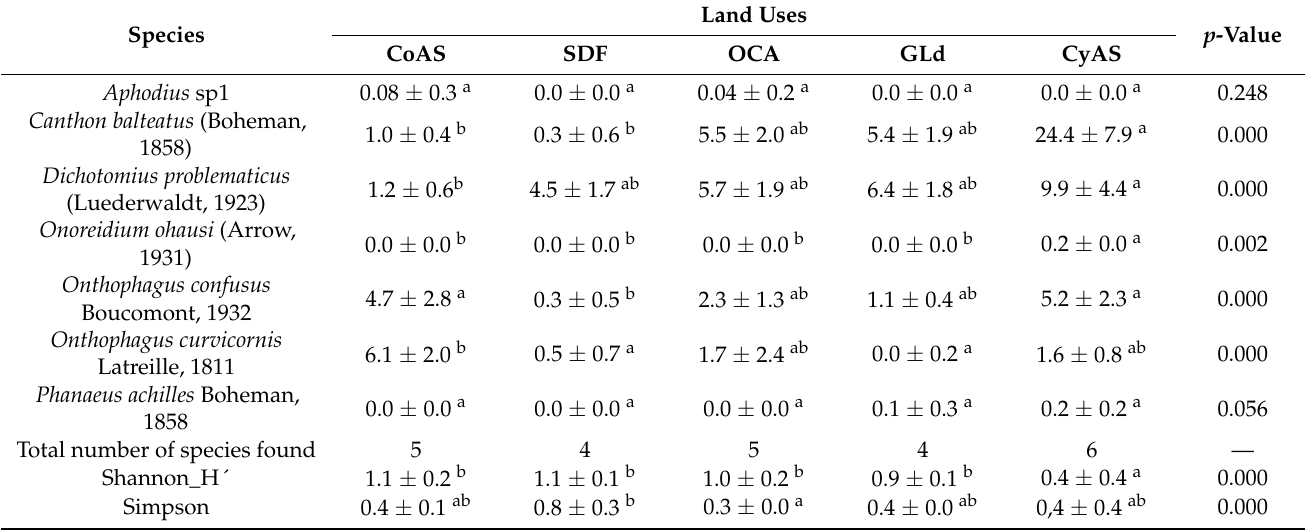
Table 4. Dung beetle species and the average number of individuals trapped in the different L-UCH classes, including the standard deviations (24 pitfall traps in each L-UCH class). The different letters mean significant difference ( p < 0.05, HSD